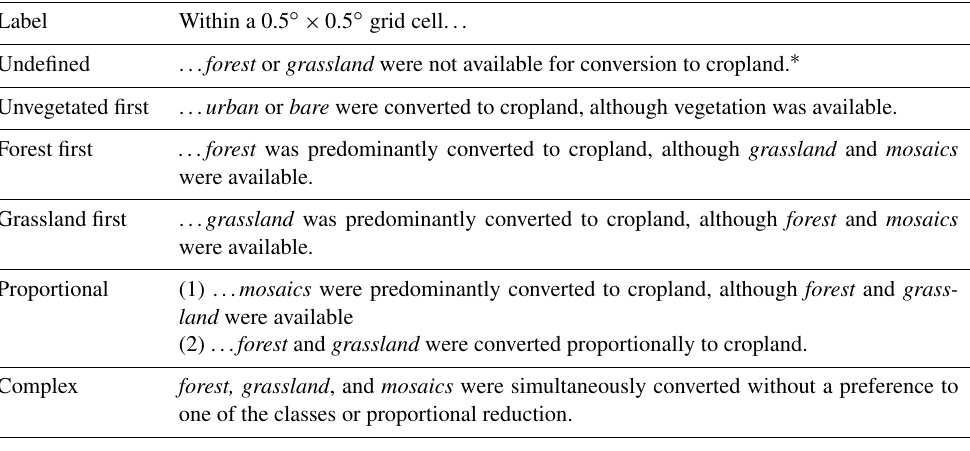
Table 3. Definition of classified algorithms in the CLUMondo exercise (Sect. 4.3). CLUMondo data were preprocessed as described in the text and Supplement Sect. S2.4. Each ca. 0.5 ◦ × 0.5 ◦ grid cell was assigned a label according to the distribution of changes seen in the higher resolution (5arcmin) CLUMondo data. Land types according to the reclassification of CLUMondo land systems are shown in Table S6; mosaics refer to a mixture of vegetation within a grid cell (e.g., forest and